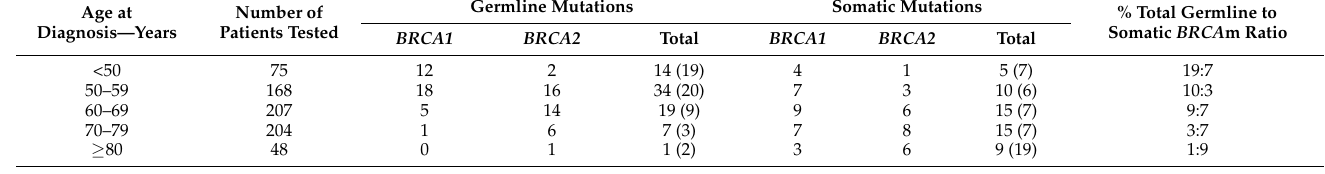
Table 2. Germline and somatic BRCA1/2 pathogenic variants categorized by age group. Data are presented as number (percentage; the denominator is the ‘Number of patients tested’ in each age group). Key: BRCA m, BRCA1/2 pathogenic variant.